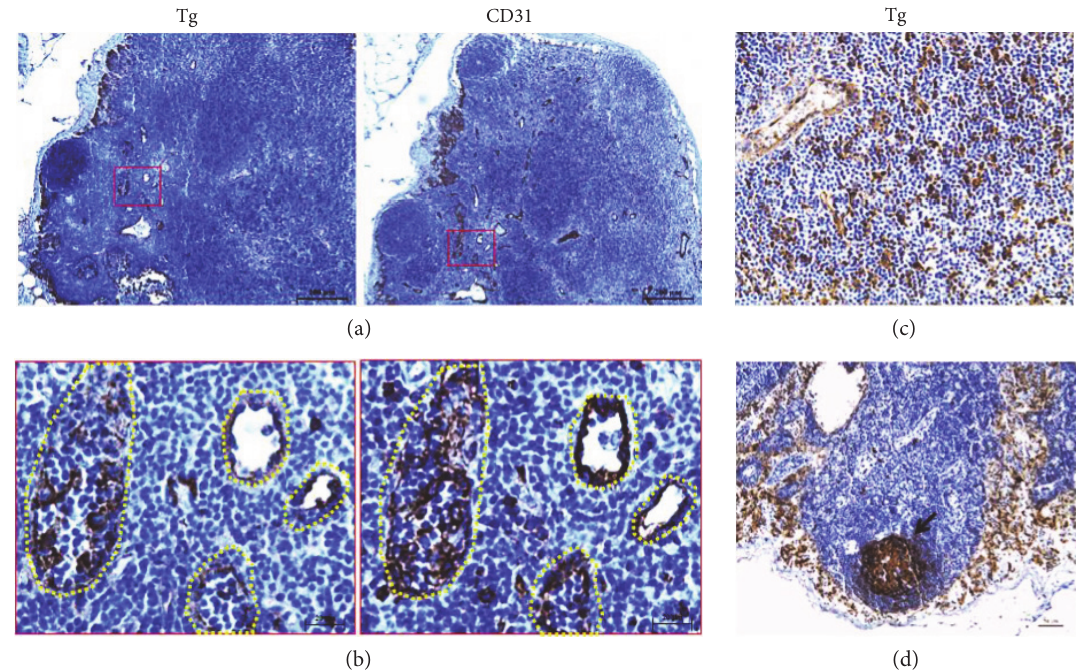
Figure 4: Expression of Tg protein in the Tg-positive thymus specimen. Thyroglobulin (Tg) was identi fi ed in the vasculature stained with the CD31 antibody (a and b). Tg was observed in thymocytes (c) and germinal center (d). The positive stained cells in the germinal center (arrows) are indicated. The low (a) and high (b) magni fi cations of the images are 100x and 400x, respectively, and (c) and (d) of the images are 400x. The scale bars represent 200 μ m (a), 20 μ m (b), and 50 μ m (c and